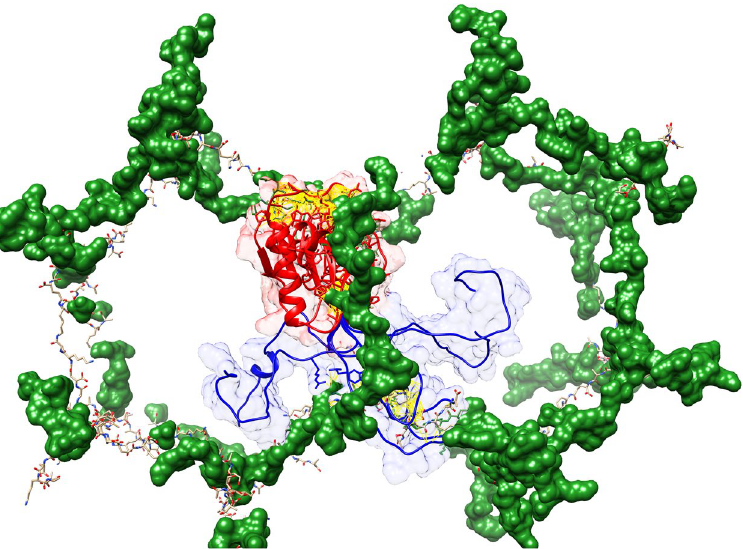
Figure 9. Model of Ts2631 endolysin binding to peptidoglycan. The Ts2631 endolysin consist two major parts: the structural part with catalytic residues (in red) and flexible N-terminal extension (in blue). Both parts are essential for peptidoglycan (in green) binding (the possible contacts are marked in yellow). While structural part is responsible for lysis of peptidoglycan (coordinated by Zn 2 + and water molecule and highly conserved catalytic triad), the N-terminal extension can adopt multiple conformations with putative contacts with peptidoglycan far away from the main body of the enzyme (the alternate conformers of the N-terminal extension had been built using Modeller software with DOPE potential) 21,22